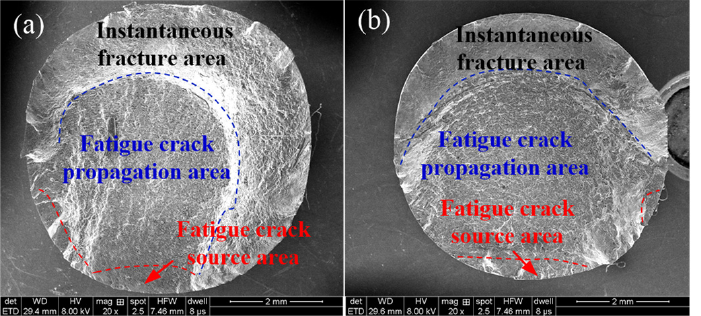
Figure 7. Macromorphology of high-temperature low-cycle fatigue fracture. ( a ) v = 70 m/min, f = 0.15 mm/rev, a p = 0.20 mm; ( b ) v = 50 m/min, f = 0.15 mm/rev, a p = 0.20 mm.